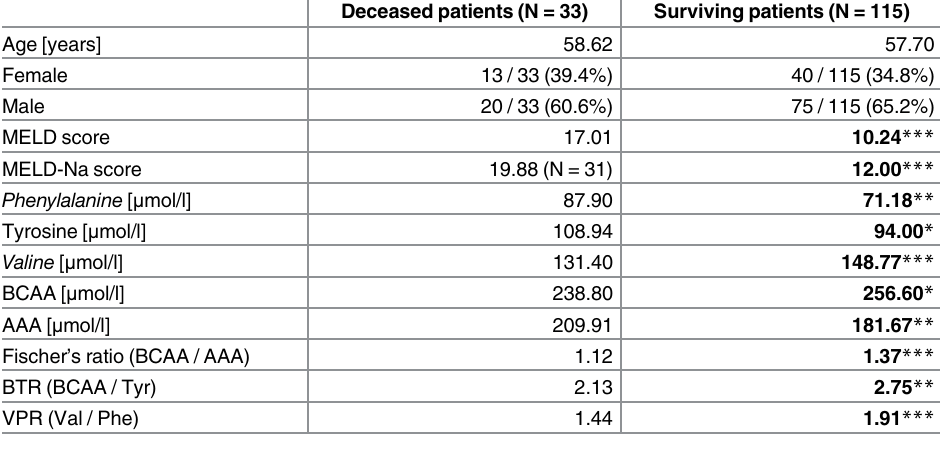
Table 4. Comparison of distributions between the deceased and surviving patients was performed using Mann-Whitney-U-Test. Patients receiving an OLT during follow-up time were excluded in this analy- sis (N = 18). Values in the table are medians. Significant results are written in bold and asterisked ( ** , *** ). Essential amino acids are printed in italics. Deceased patients (N =